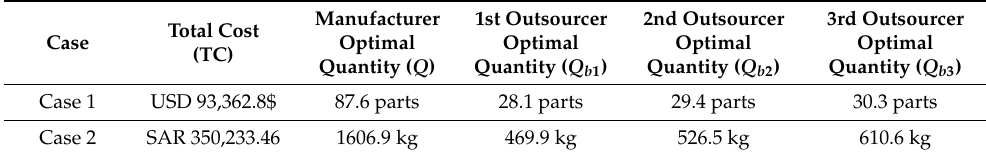
Table 7. Optimal results, with respect to production and outsourcing quantity, for two cases (where 1USD = 3.75 SAR).